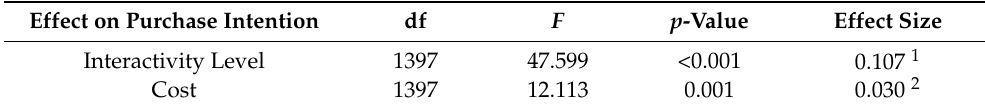
Table 1. Effects on Purchase